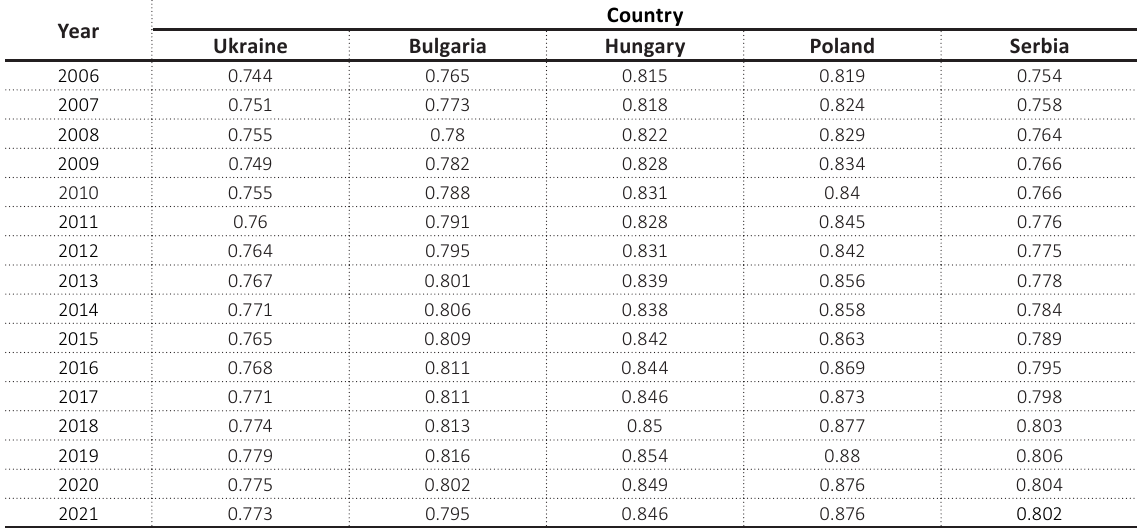
Source: UNDP HDR (2022).